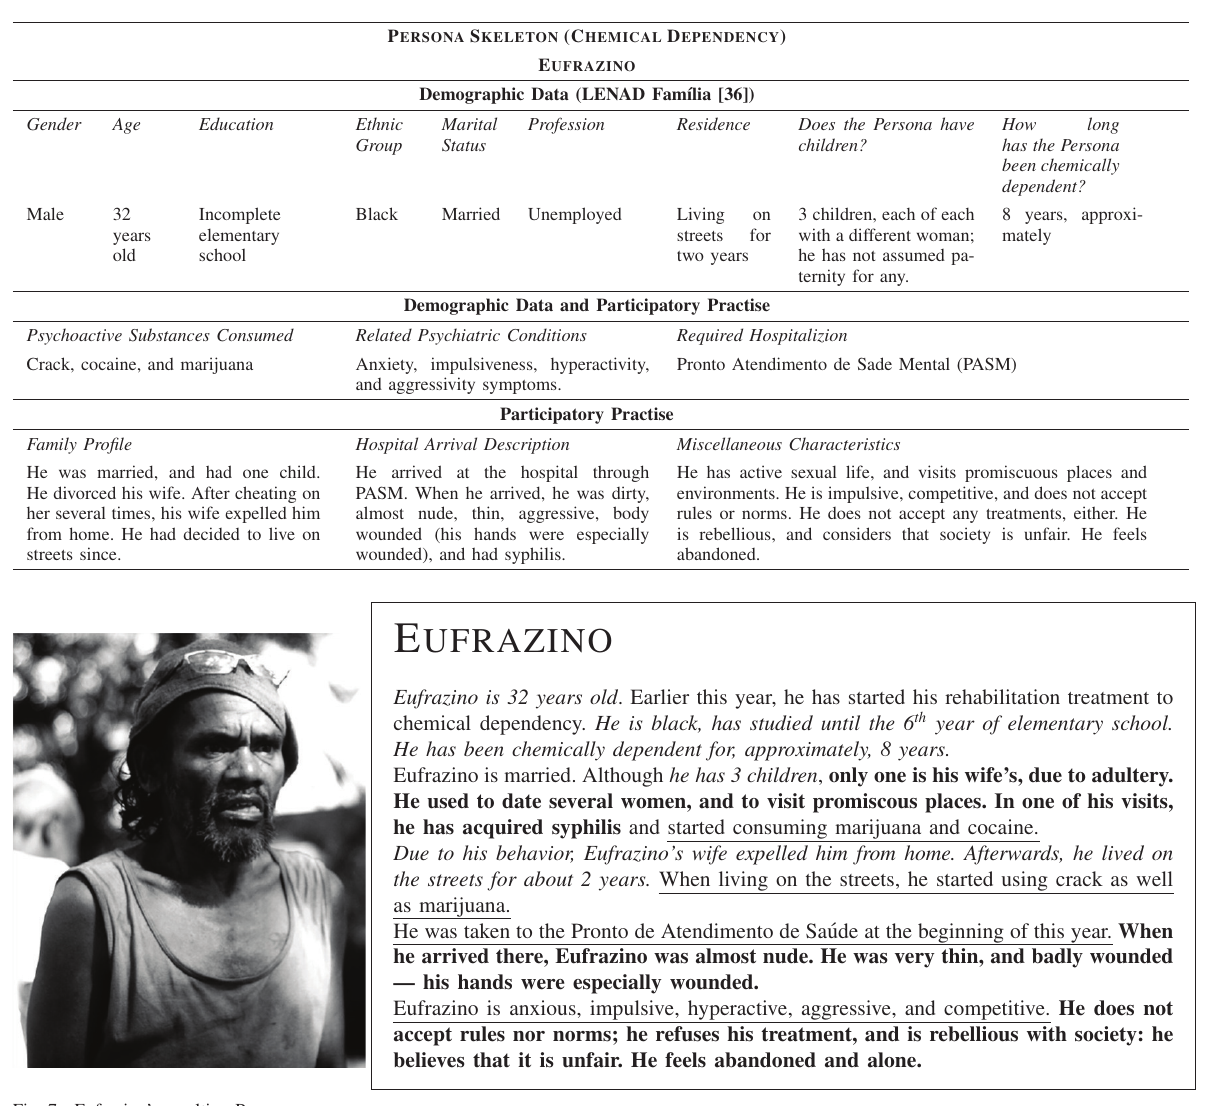
used to convey the data source are the same as above. Carmelita represents a fictitious depressive patient. The design process to create her was similar to Eufrazino’s: the design team conceived her at Familiar Planning, and Conception and Gestation phases, and improved her at Birth and